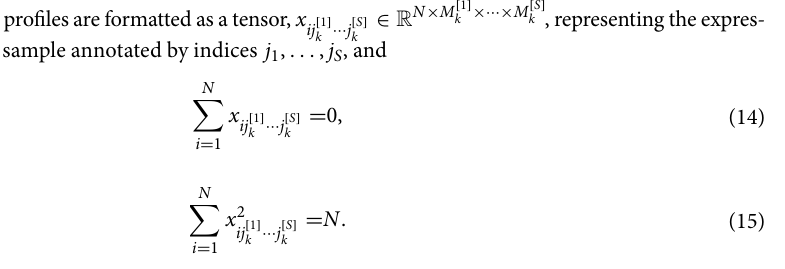
1 ] [ S ] ∈ R N × M [ k ×···× M k , representing the expres- ij [ 1 ] k ··· j [ S ] k